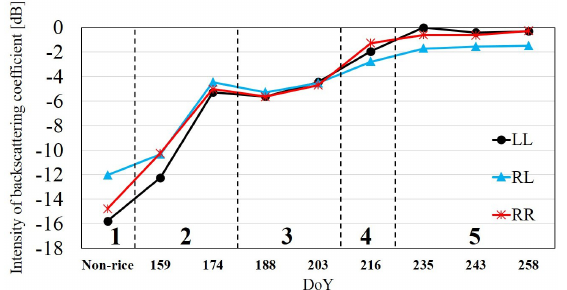
Figure 6. Backscattering coefficients of LL, RL, and RR